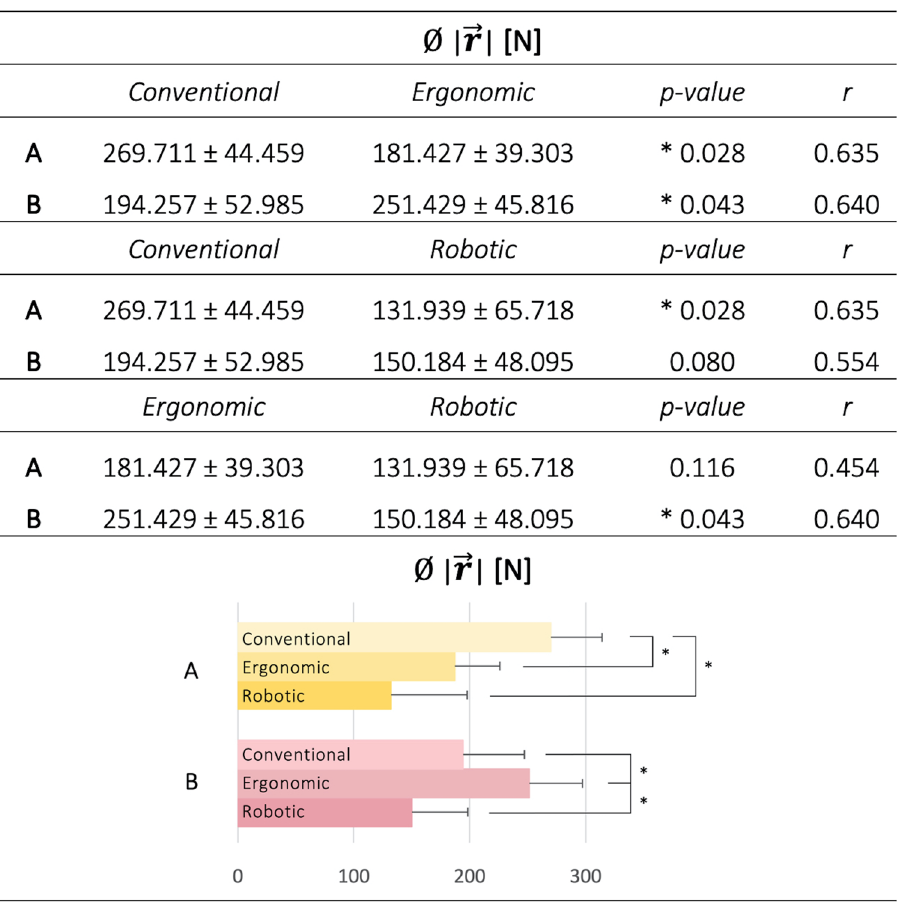
Table 3. Intra-group comparison of the mean |